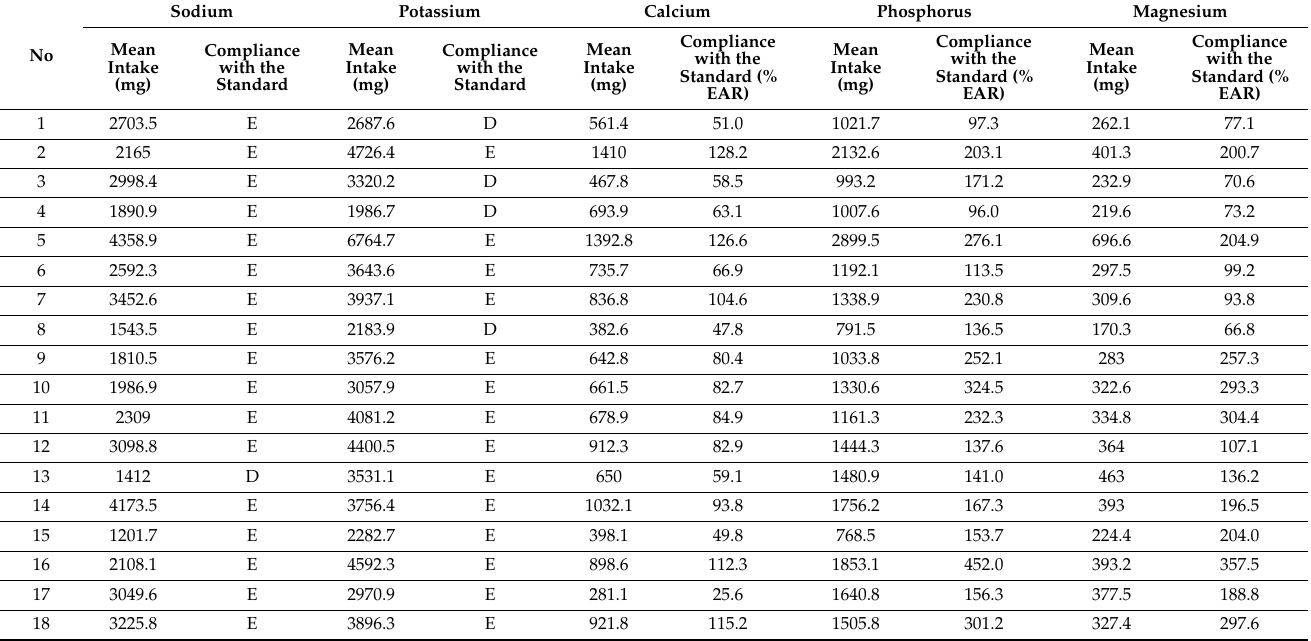
Table 6. Dietary intake of selected minerals with DFRs among people with